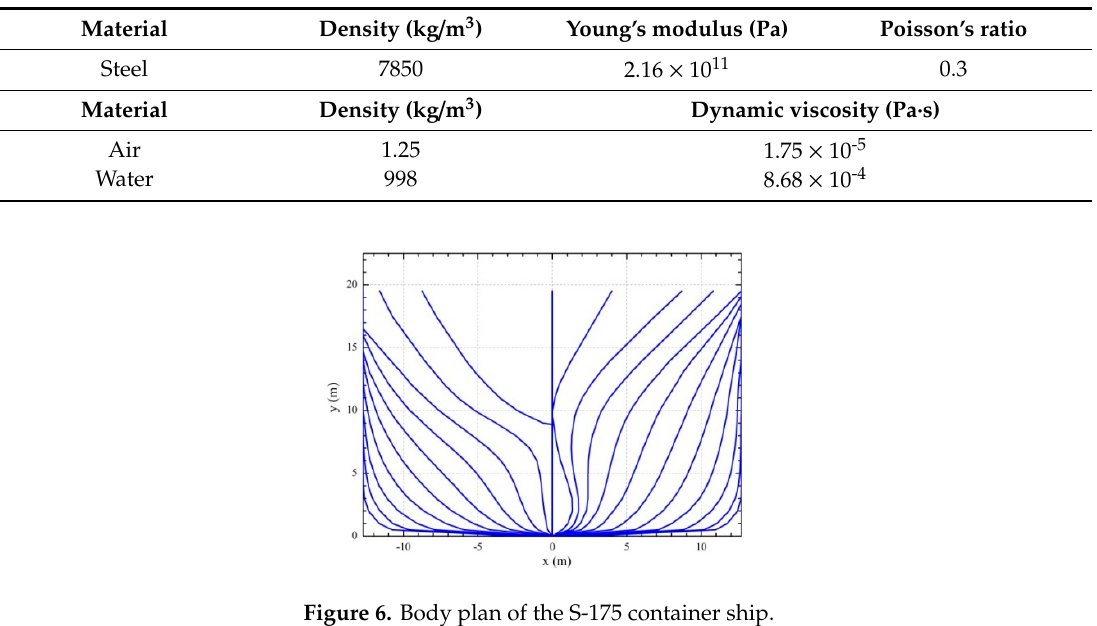
Figure 6. Body plan of the S-175 container ship.